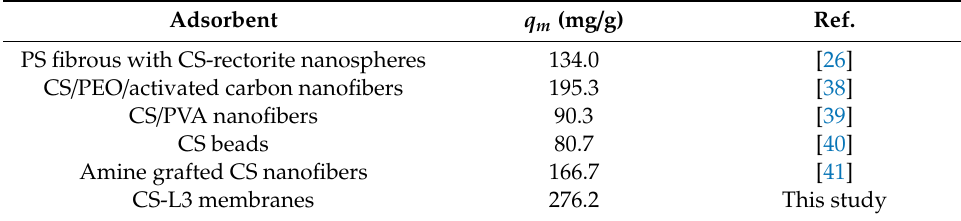
Table 5. Comparison of adsorption capacity of CS-L3 toward Cu(II) with other reported adsorbents. Adsorbent q m (mg / g) Ref. PS fibrous with CS-rectorite nanospheres